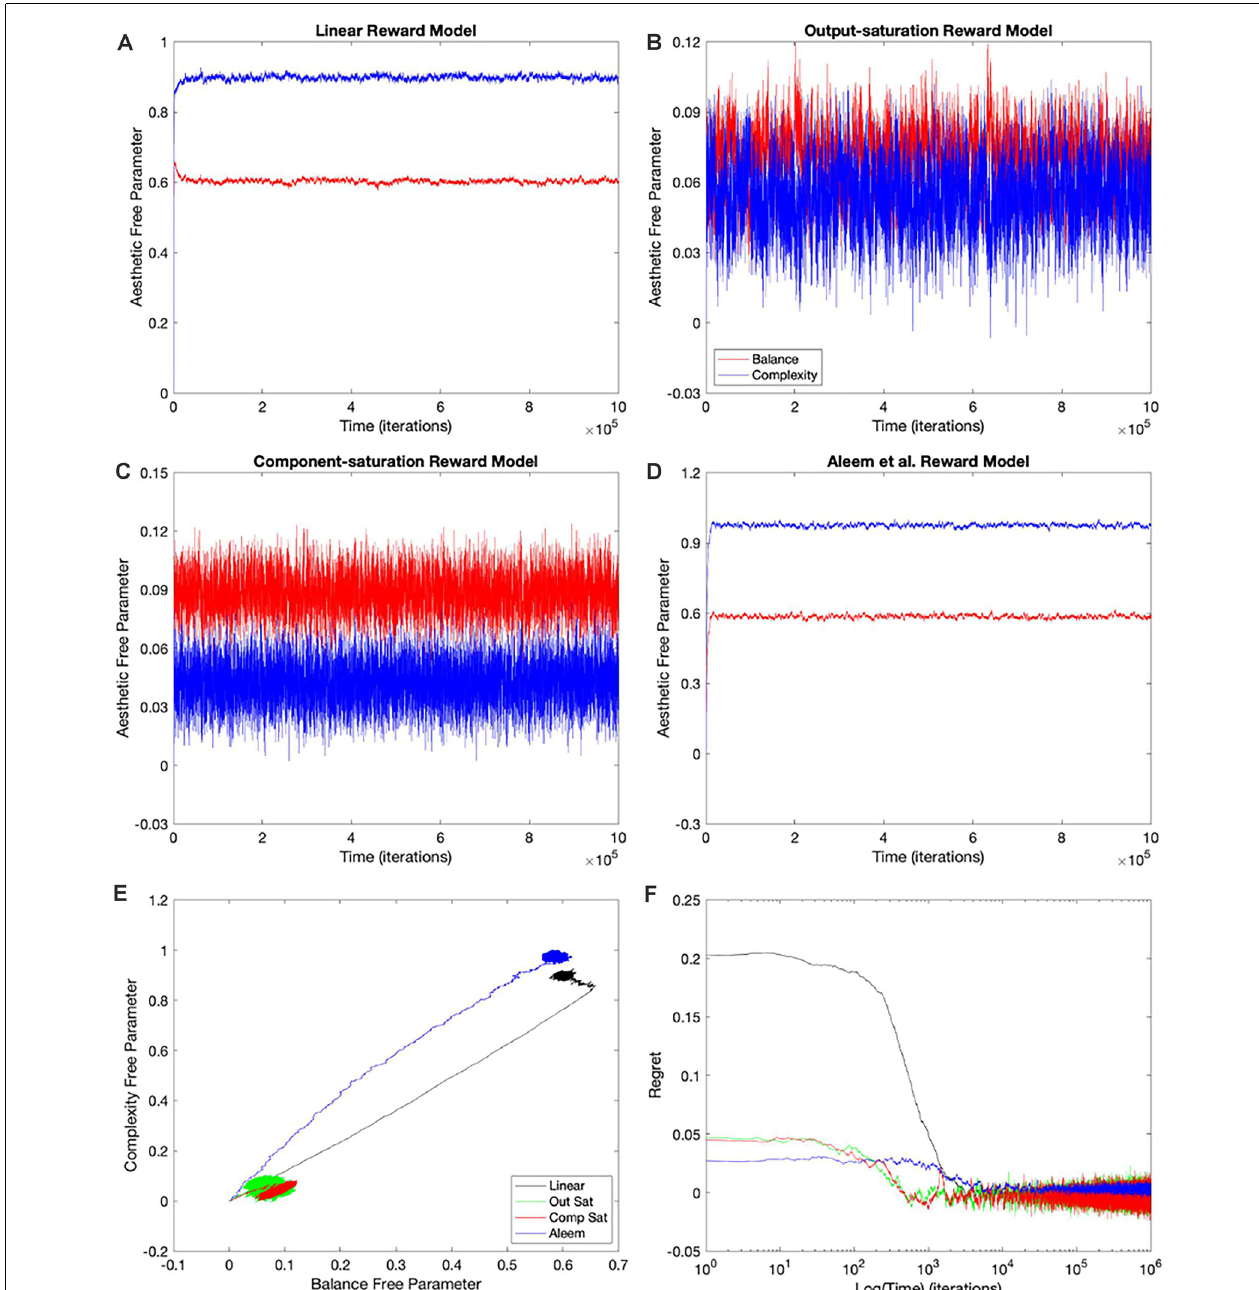
FIGURE 6 | Dynamics of the free parameters of the value function for the shortest-path (Phi Rule) conditions ( Table 1 ). The conventions for this figure are the same as those for Figure 2 . The free-parameter and phase-diagram results here are qualitatively like those in Figure 5 , with minor apparent quantitative differences (Panels A–E ). However, although the changes in the free-parameter curves are subtle, the improvement of the regrets are dramatic (Panel F ).